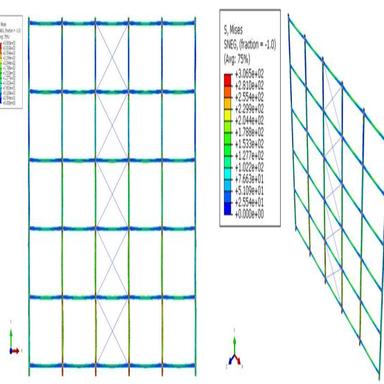
SR4: Von Mises stress-distribution at the middle surface at the peak load.